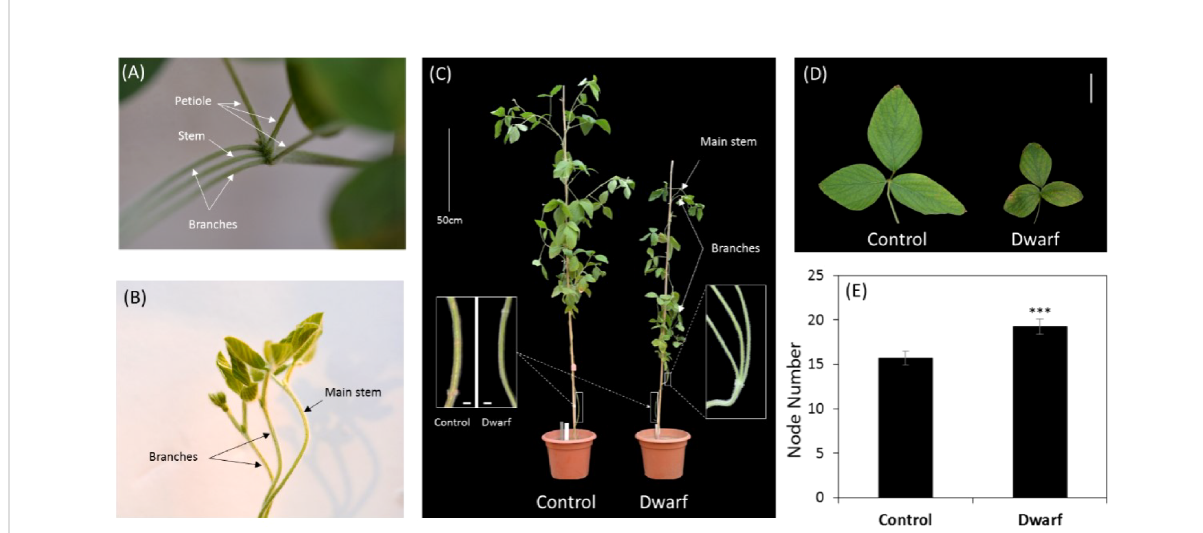
FIGURE 1 Phenotypic characterization of soybean dwarf mutant. (A) Two branches and three petioles on the fourth node of dwarf mutant (V6 stage), as indicated by white arrows. (B) Top view of branches from the fourth node (V6 stage), as indicated by black arrows. (C) Full view of dwarf mutant and control (R2 stage). Stem thickness was shown for the third node in the left rectangle; Branches of dwarf mutant was enlarged in the right rectangle, and branch apexes were indicated by white arrows. (D) leaf size of the ninth node (R5 stage), scale bar =5 cm. (E) Comparison of node number of M 3 plants of the dwarf mutant and control, n=9,*** represents Student ’ s t-test P<